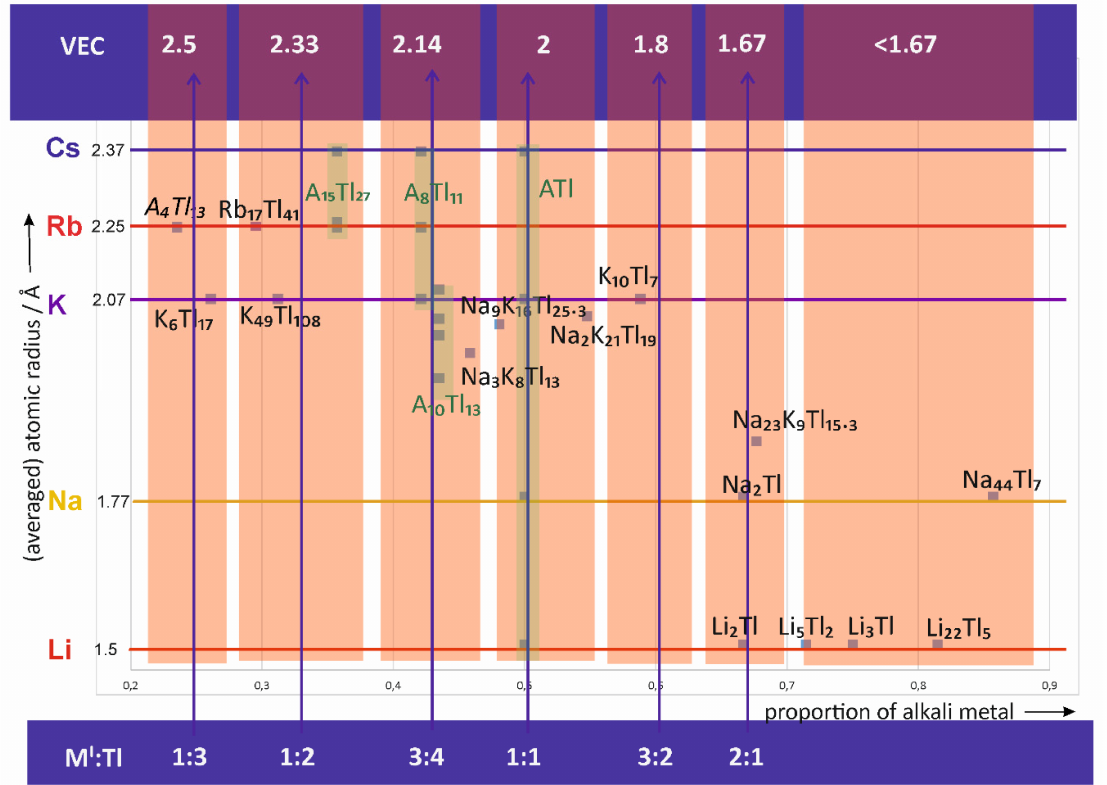
Figure 1. General map of the so far reported alkali metal thallides in dependence of their proportion and size of the involved of alkali metal(s). Areas of approximant ideal combinations M I :Tl are highlighted and the corresponding valence electron concentration (VEC) is given.. For A 4 Tl 13 (A = Rb, Cs) no structural data is available. The structural family A 15 Tl 27 includes the reported compounds Rb 15 Tl 27 , Rb 14 CsTl 27 and Cs 15 Tl 27 . A 8 Tl 11 binary phases are known for K 8 Tl 11 , Rb 8 Tl 11 and Cs 8 Tl 11 . The reported ternary A 10 Tl 13 phases follow the formula Na 4 A 6 Tl 13 where A = K, Rb Cs. Binary ATl is known for A = Li, Na, K,